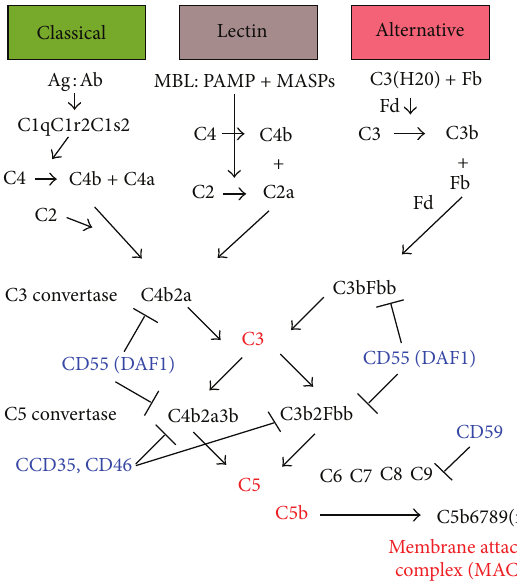
Figure 1: Overview of the complement system. Stimulated by